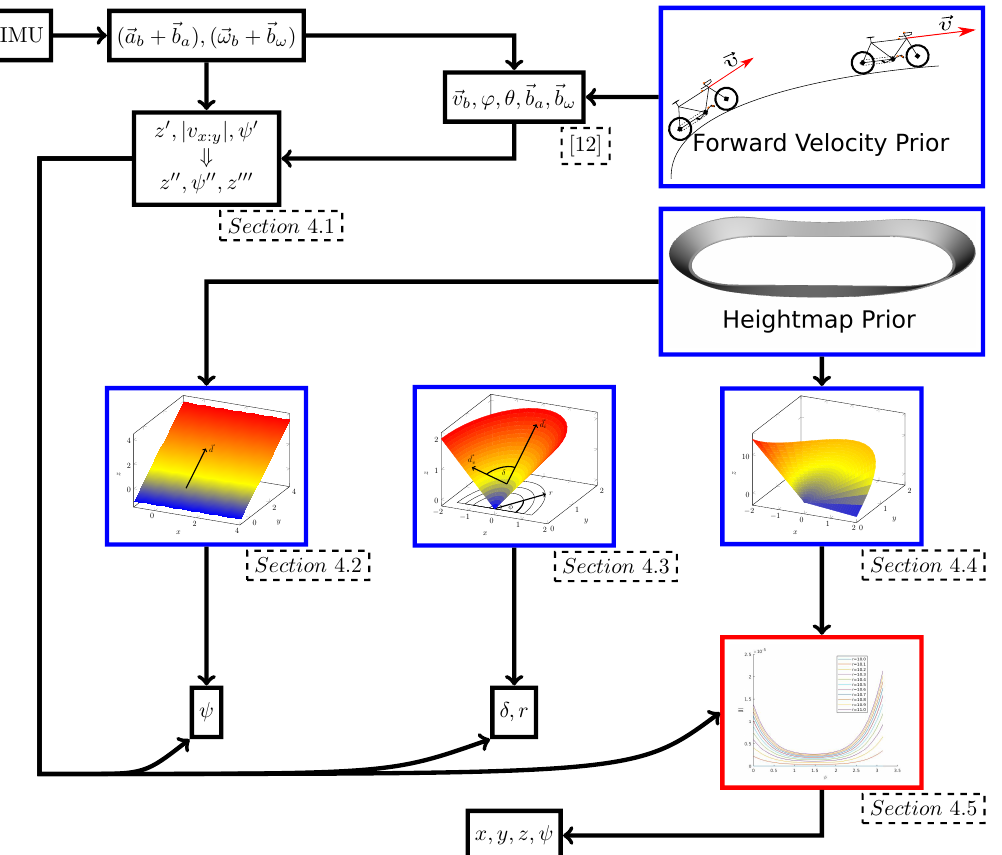
Figure 7. Overview of the observability analysis. The available information is arranged in the boxes. The arrows show which information is required to infer additional information. Blue boxes show the prior knowledge. Information in the red box is retrieved by numeric analysis, whereas all other information is derived